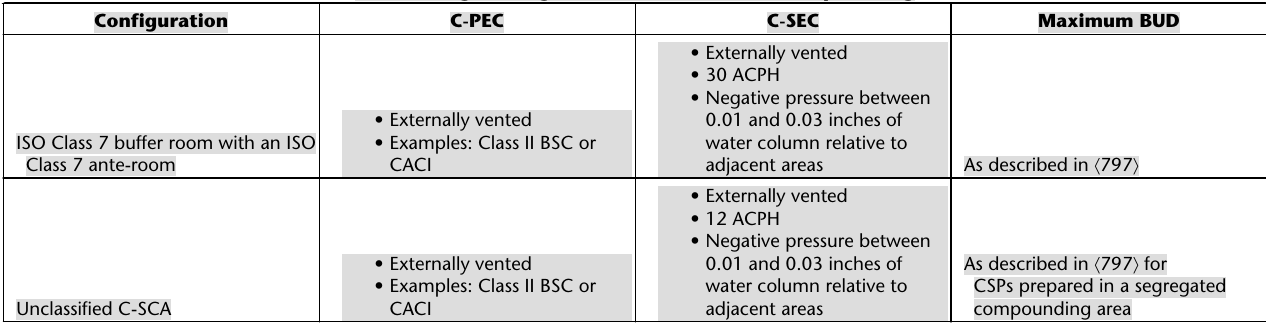
Table 3. Engineering Controls for Sterile HD